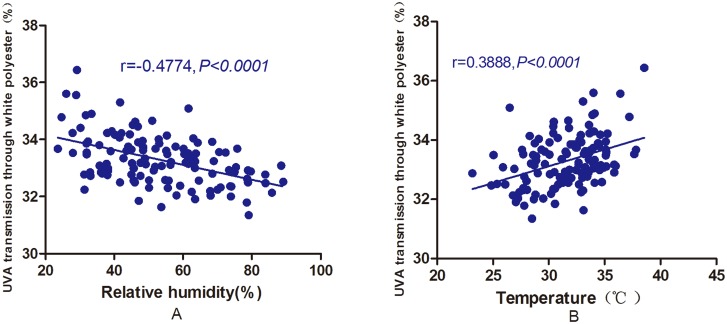
The relationship between environmental relative humidity and temperature and UVA transmission through white polyester.A: Pearson’s correlation analysis revealed a significant negative correlation between relative humidity and UVA transmission through white polyester (r = -0.4774, P<0.0001). B: Pearson’s correlation analysis showed a significant positive correlation between temperature and UVA transmission through white polyester (r = 0.3888, P<0.0001).